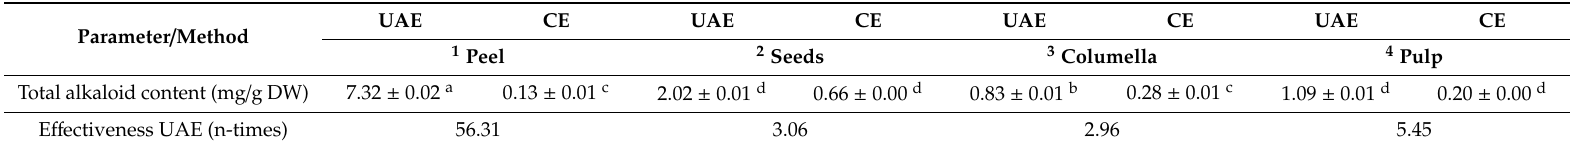
Table 5. Total alkaloid content and yield in peel, seed, columella, and pulp of Annona muricata using the optimal conditions of ultrasonic-assisted extraction and conventional